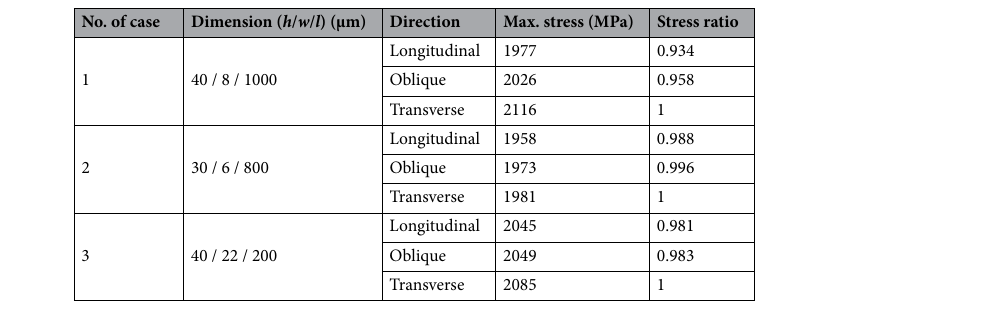
Table 2. Comparison of effective stress in various